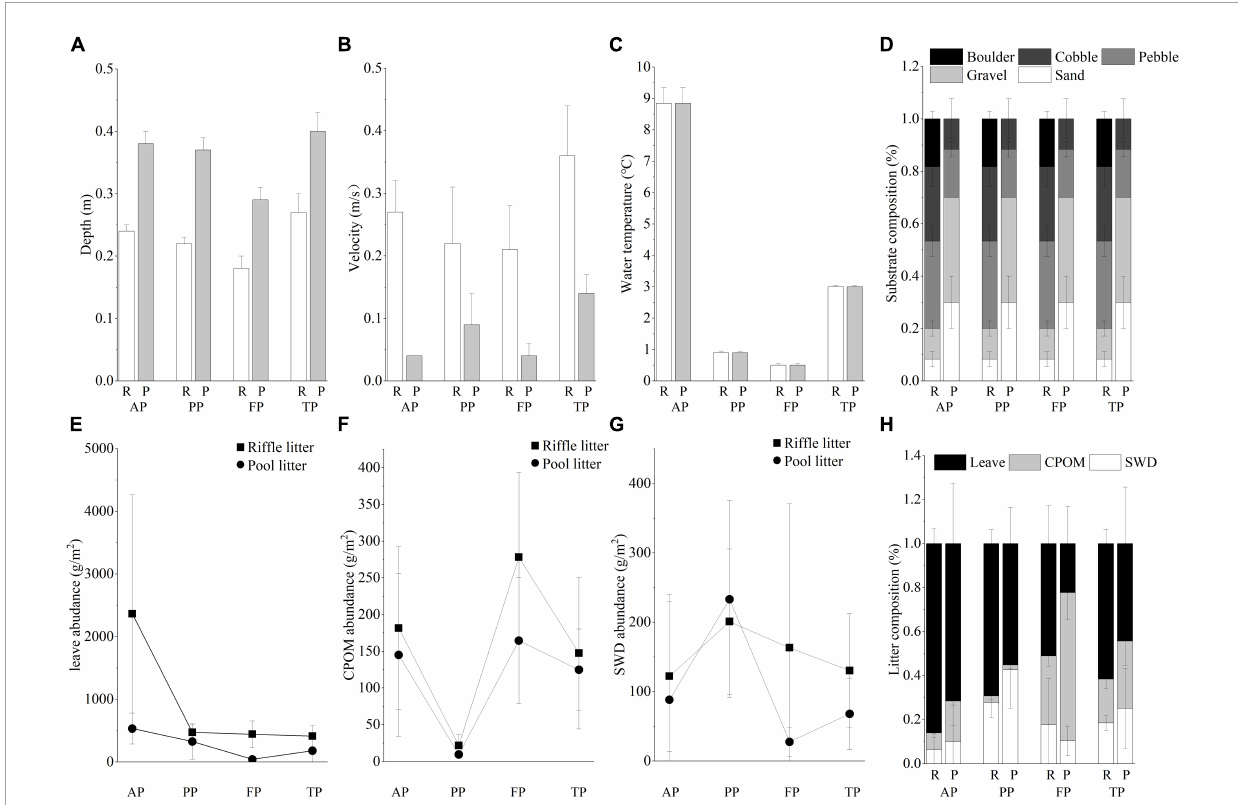
FIGURE3 Physical environmental conditions: (A) depth, (B) velocity, (C) water temperature, (D) substrate composition in riffles and pools during the four periods; and litter composition: (E) leave abundance, (F) CPOM abundance, (G) SWD abundance, and (H) relative abundance of each litter type in the riffle and pool litter patches during the winter. R, riffles; P, pools; AP, the autumn period; PP, the pre-freezing period; FP, the freezing period; TP, the thawing period; CPOM, coarse particulate organic; SWD, small woody